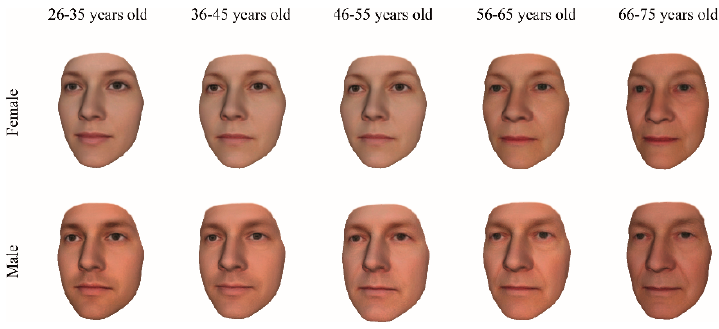
Figure 4. Rendering results of 3D face templates for five age groups from adulthood to a geriatric age.